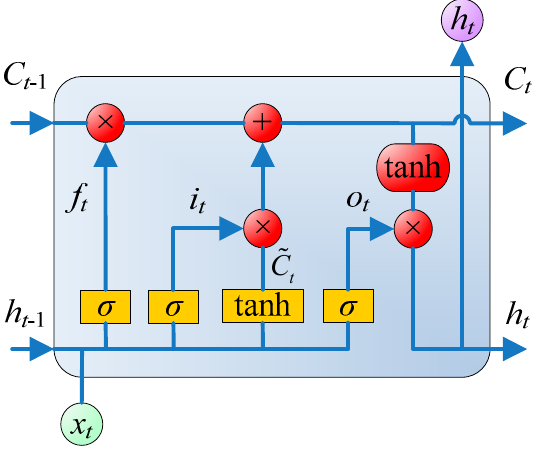
Figure 3. The Long Short Term Memory network (LSTM) structure.